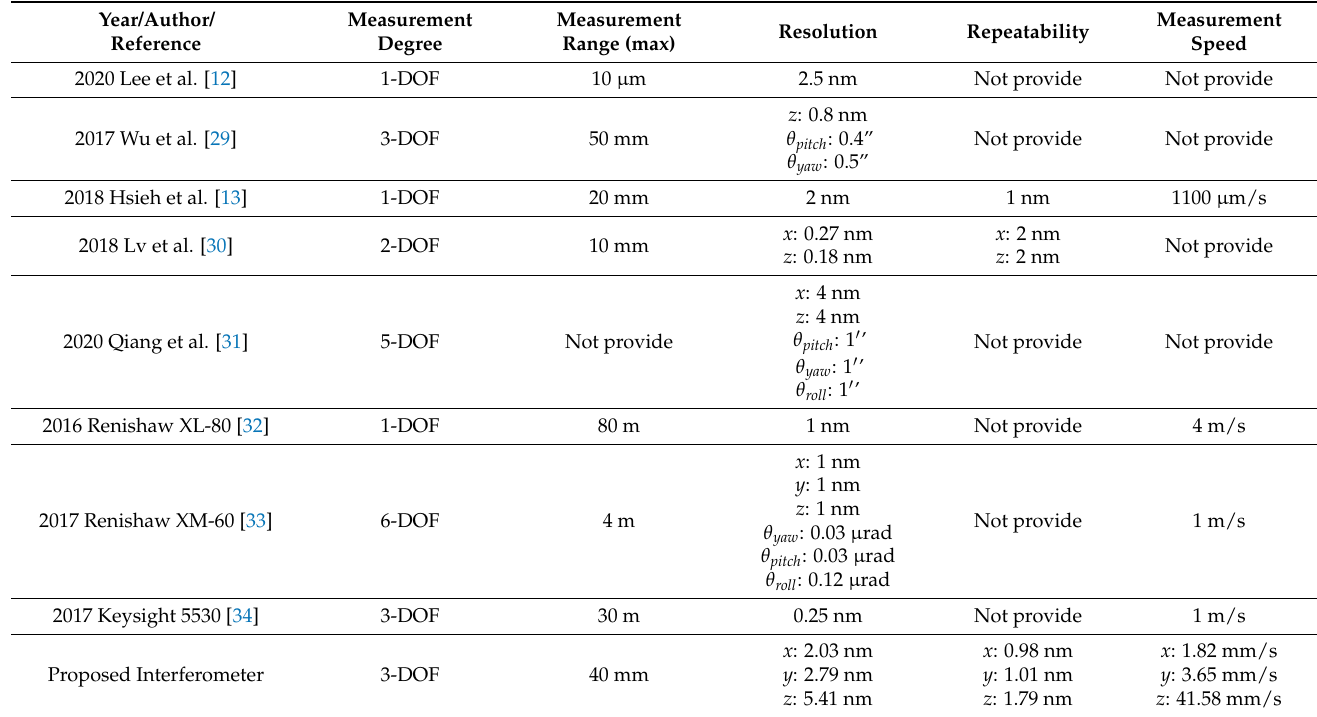
Table 3. Comparison with state-of-art